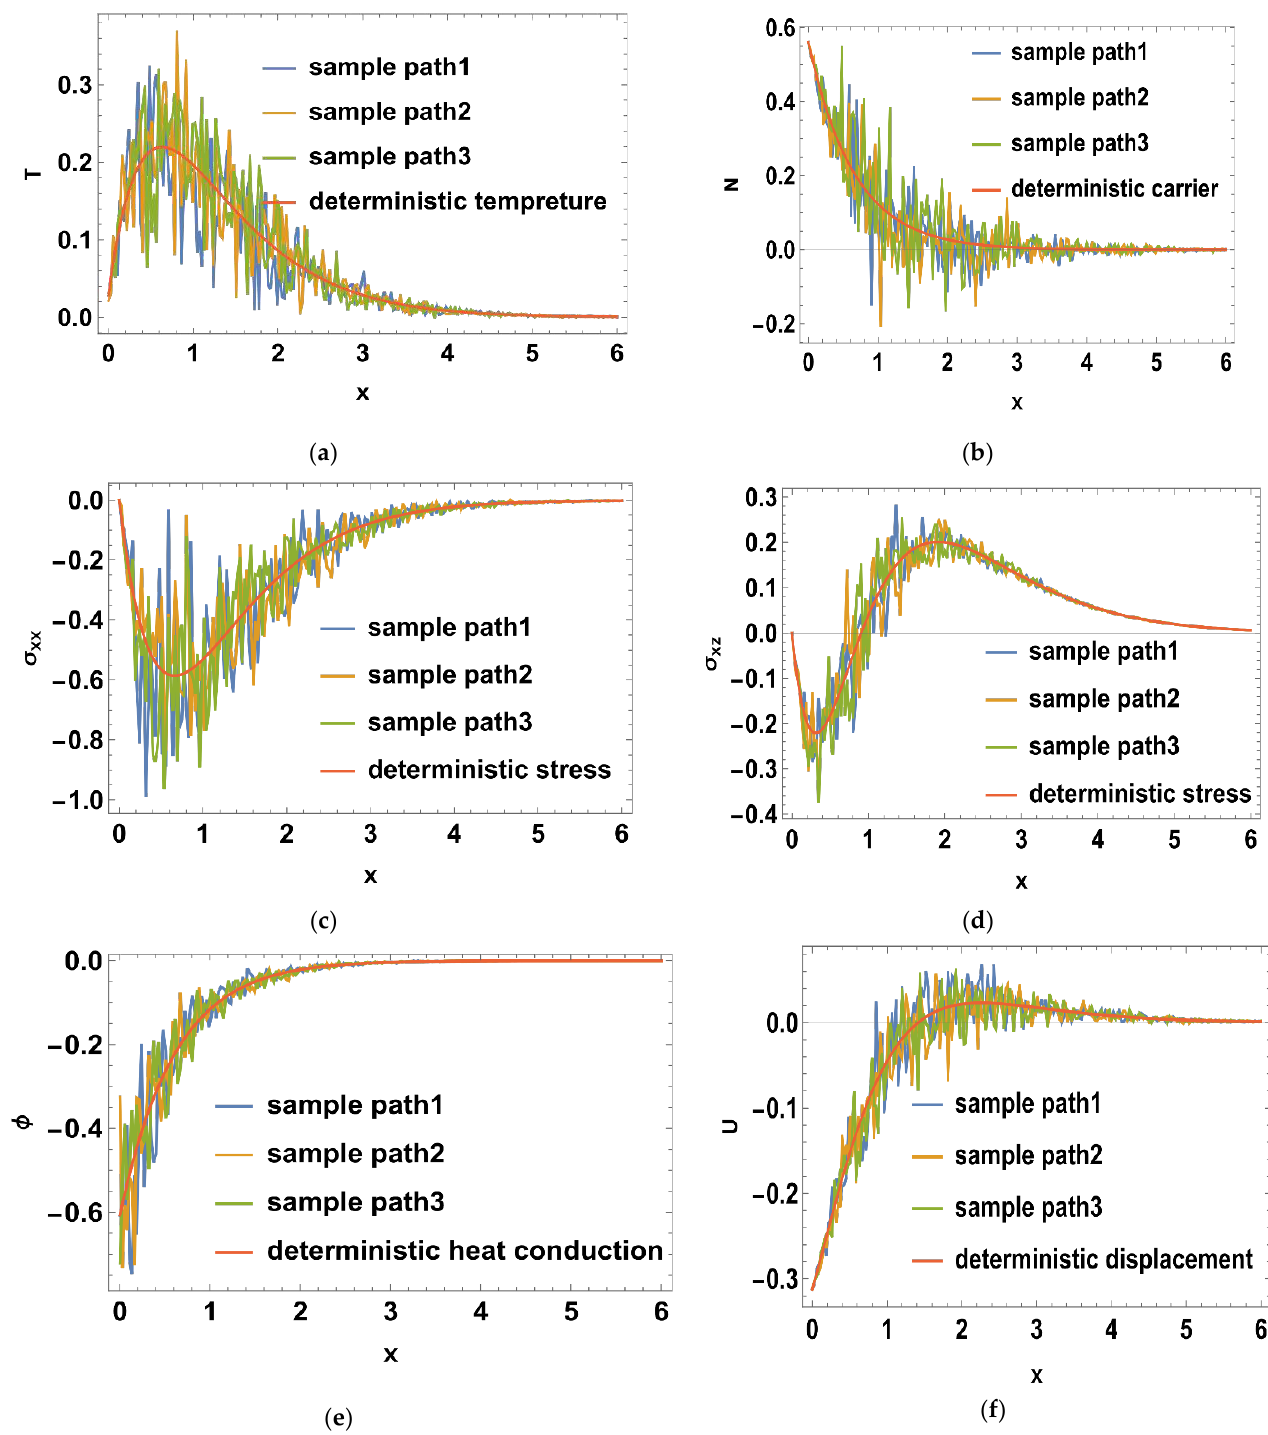
Figure 1. ( a – f ) The deterministic temperature, normal stress, carrier density, displacement and heat conduction distributions along the distance for various values of times in relation to generalized photothermoelasticity theory when 5 a = .